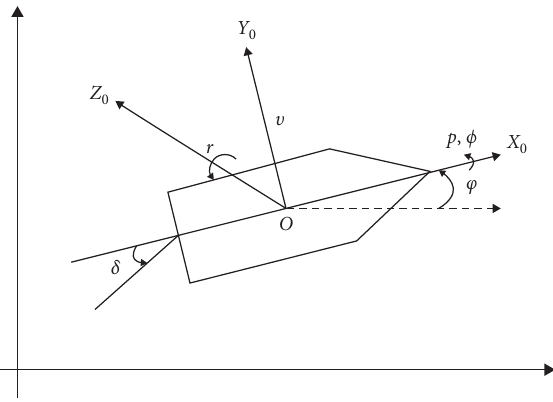
Figure 1: Motion coordinate system for X , Y , and Z denote the longitudinal axis, transverse axis, 0 0 0 and normal axis, respectively.